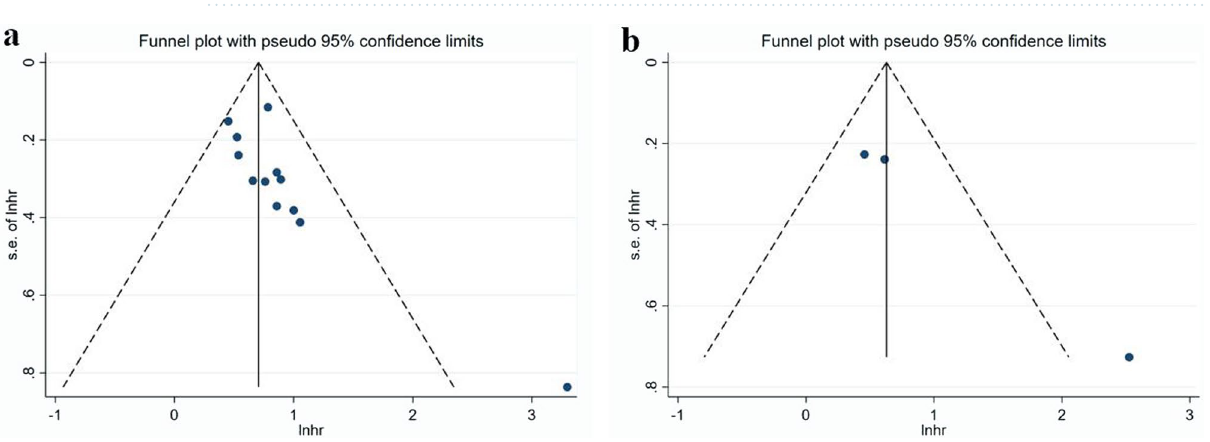
Figure 3. The sensitivity analysis of included cohorts. ( a ) For OS; ( b ) for RFS by multivariate analytic results.